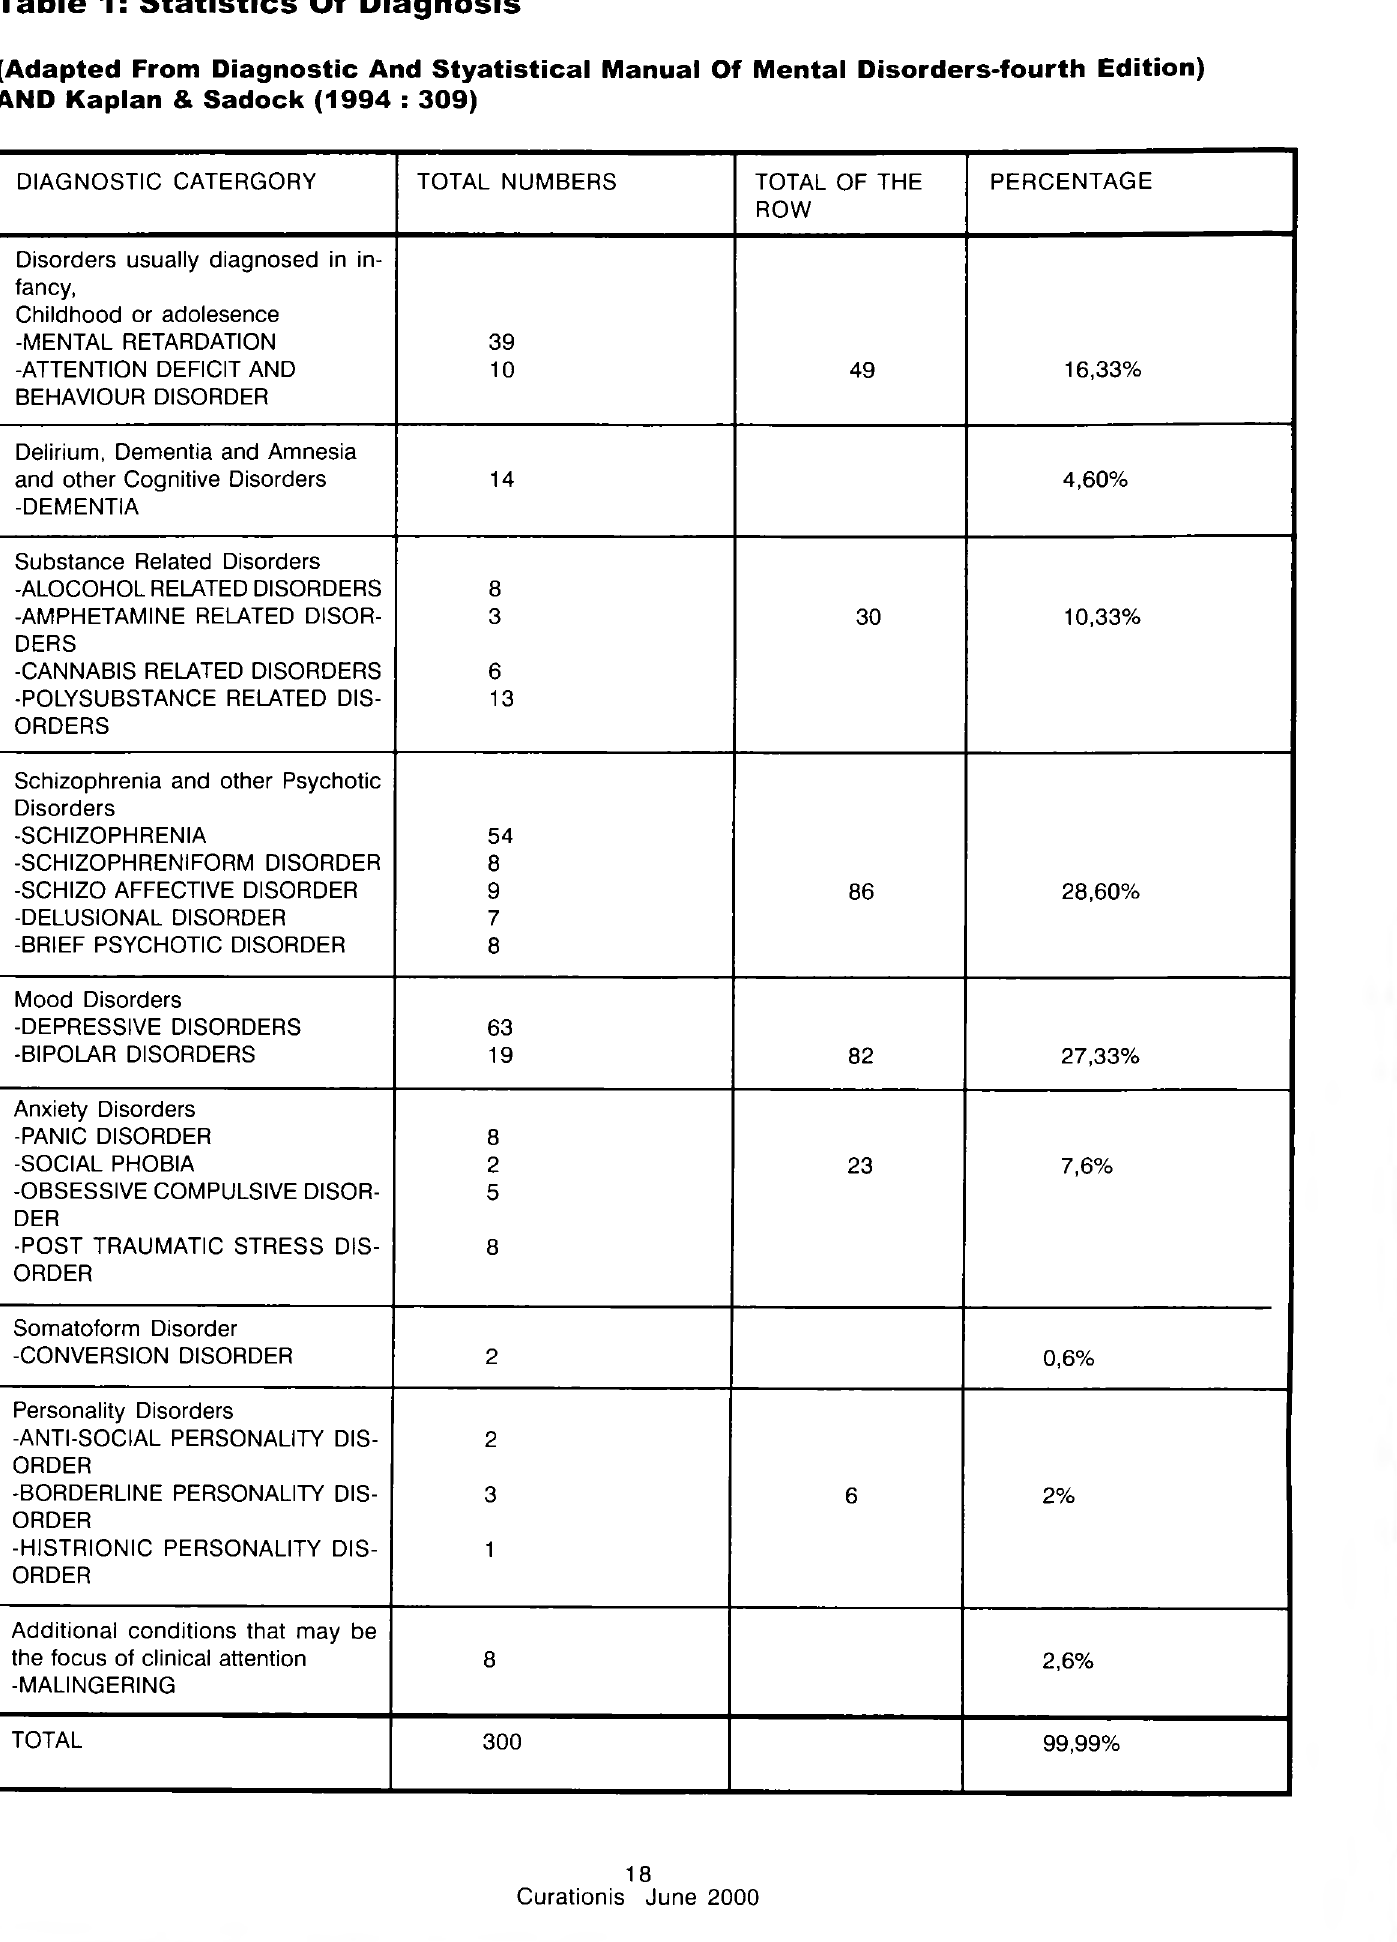
Table 1: S tatistics Of Diagnosis (Adapted From Diagnostic And Styatistical Manual Of Mental Disorders-fourth Edition) AND Kaplan & Sadock (1994 :